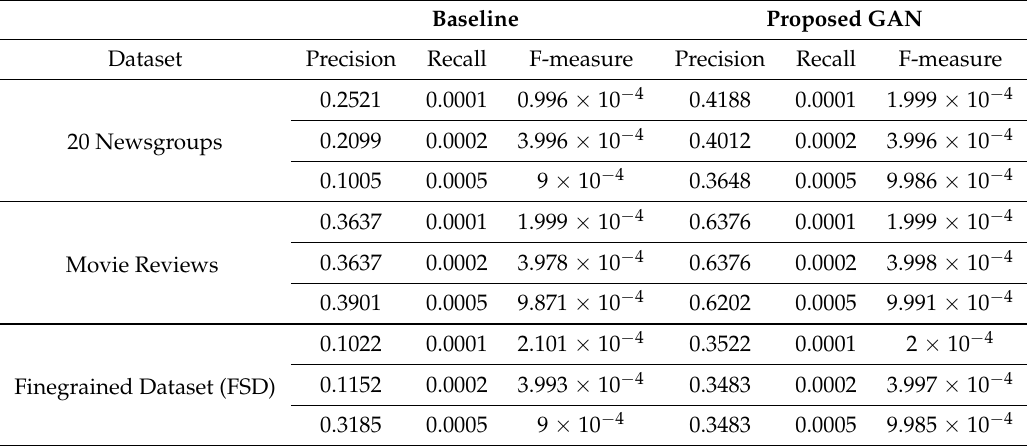
Table 3. Our proposed GAN model’s performance as a generative model when using various amounts and types of data at the document, sentence, and aspect level, compared with a simple GAN, which serves as our baseline.